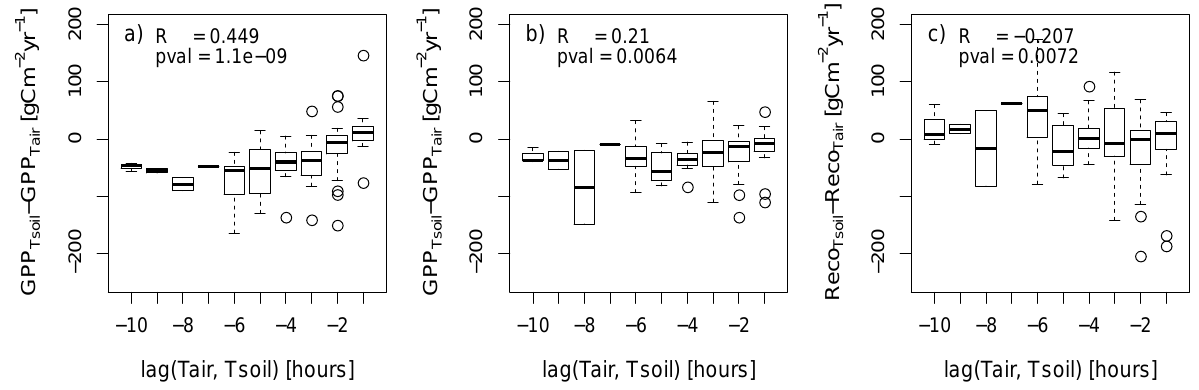
Fig. 10. Annual differences between the carbon fluxes estimated with soil and air temperature versus lag between air and soil temperature for the Reichstein et al. (2005) (a) and Lasslop et al. (2010) (b) , (c) approach. Note that for the Reichstein et al. (2005) approach results are the same for both components.